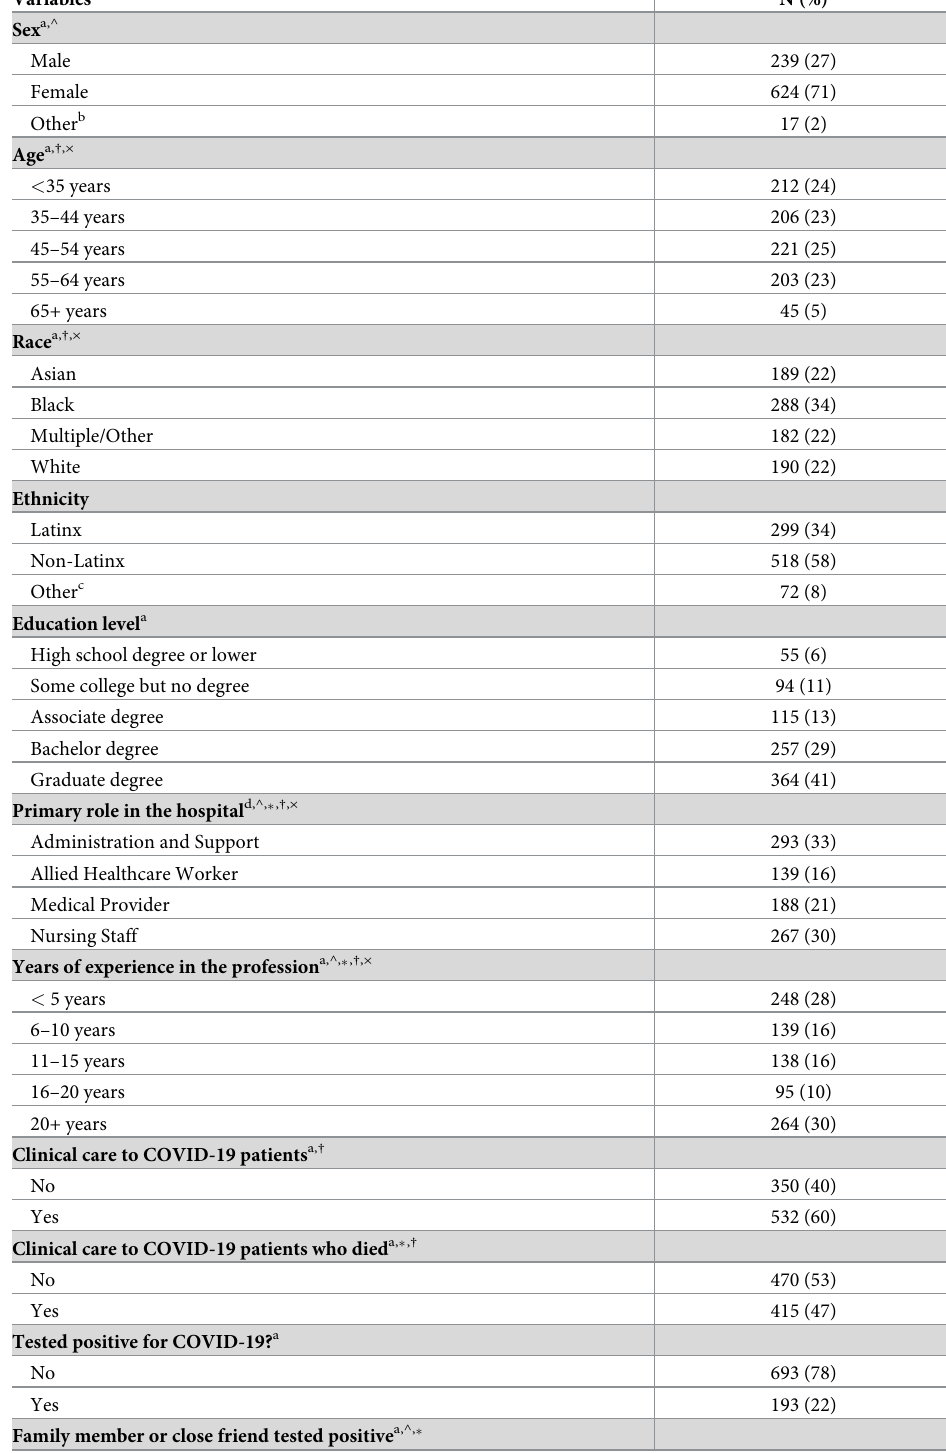
Table 1. Demographic, occupational, life circumstance and health characteristic of Lincoln Hospital survey respondents (n =